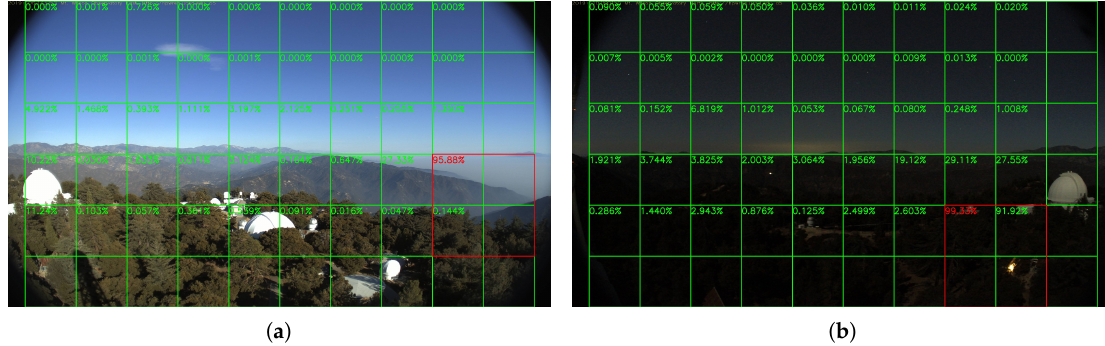
Figure 21. False Alarms. ( a ) False alarm because of dust, 3 November 2019. ( b ) False alarm because of light, 10 November 2019.